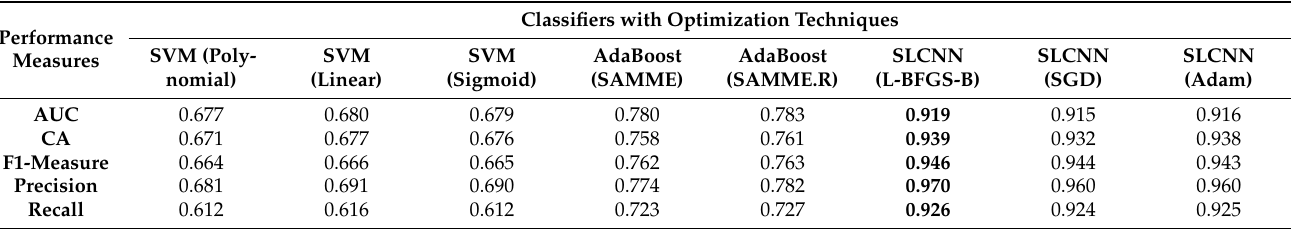
Table 6. Performance Measurement During Training for Text-Based Sentimental Classification (Training).